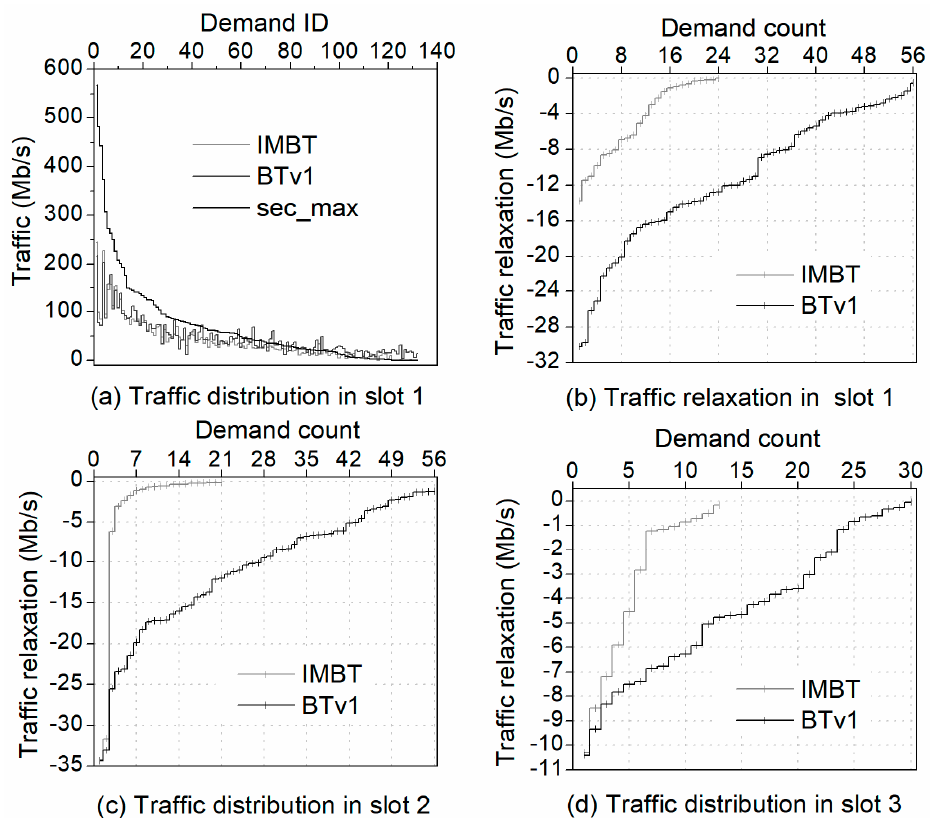
Figure 9. Tra ffi c distribution and tra ffi c relaxation distribution of Abilene (under the size of BT group Figure 9. Traffic d istribution and traffic relaxation distribution of Abilene (under the size of BT group is 200). ( a ) is the tra ffi c distribution of business requirements of IMBT, BTv1 and peak, ( b – d ) is the is 200). ( a ) is the traffic distribution of business requirements of IMBT,BTv1 and peak, ( b ), ( c ), ( d ) is tra ffi c relaxation in slot 1,slot 2 and slot the traffic relaxation in slot 1,slot 2 and slot 3.